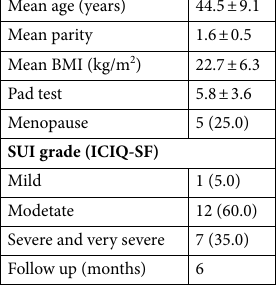
Table 1. Demographic data (n = 20) are given as mean ± standard deviation or n(%). BMI, body mass index, Values are expressed as mean ± standard deviation or numbers; SUI grade according to ICIQ-SF: slight (1–5),